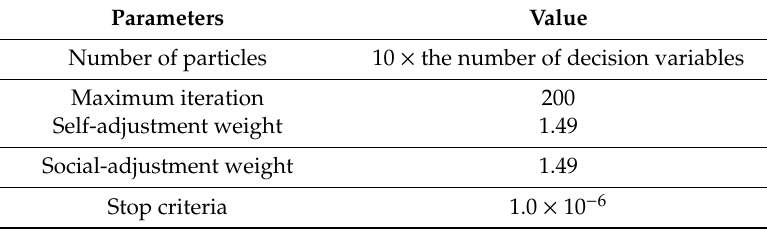
Table 3. Particle swarm optimization algorithm parameters used in this